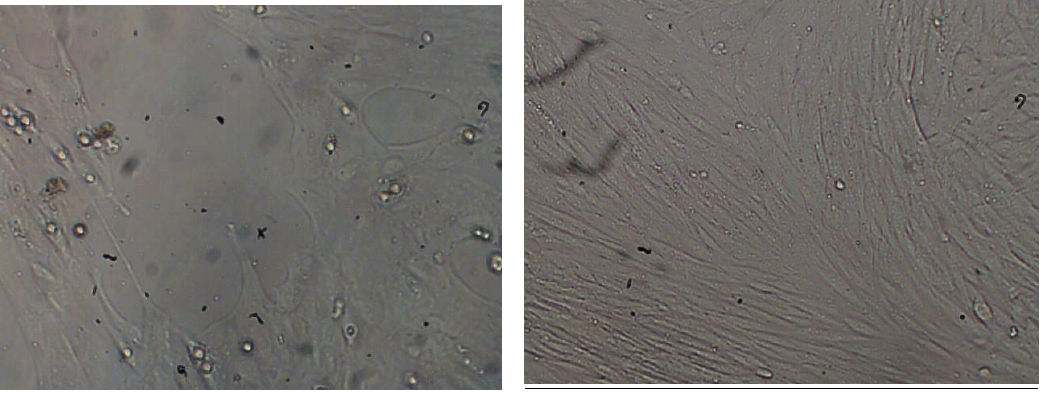
Figure 1: infected SEBK cells with BPIV-3(4 passages), after 7 days of virus inoculation, opaque foci of cells, focal rounding of cells with small and large syncytia formation. 100X Figure 2: normal SEBKcells